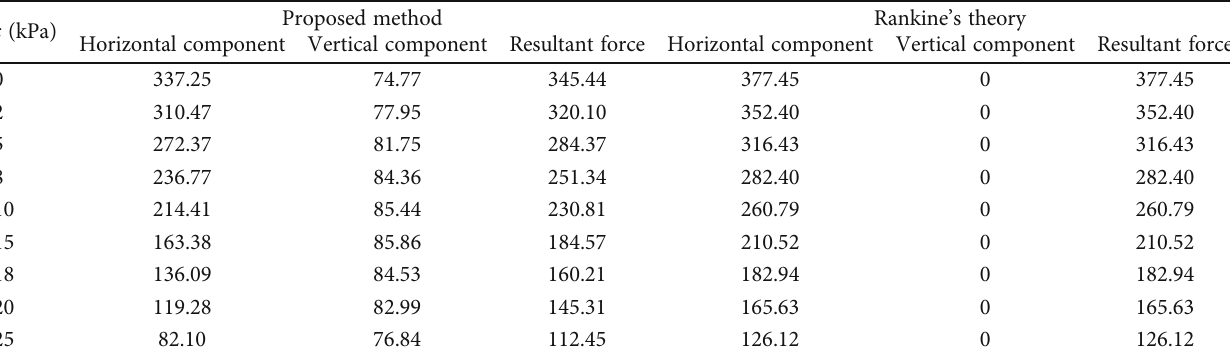
Table 1: The horizontal and vertical components of the active earth pressure (kPa).